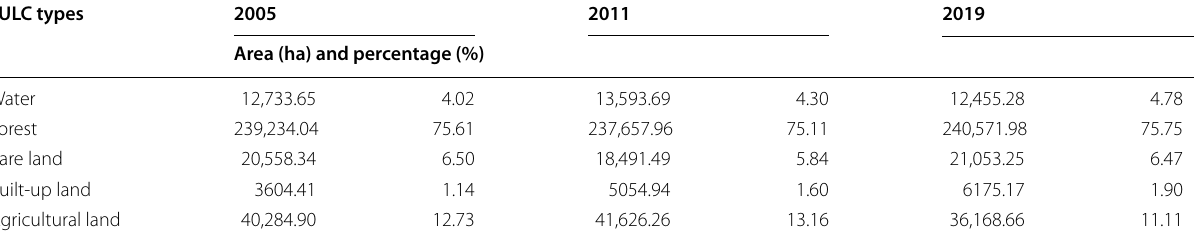
Table 2 Descriptive information on LULC